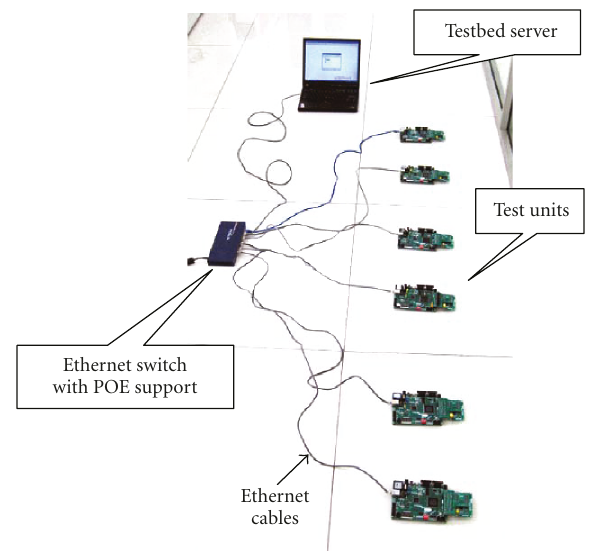
Figure 15: An experiment scenario of